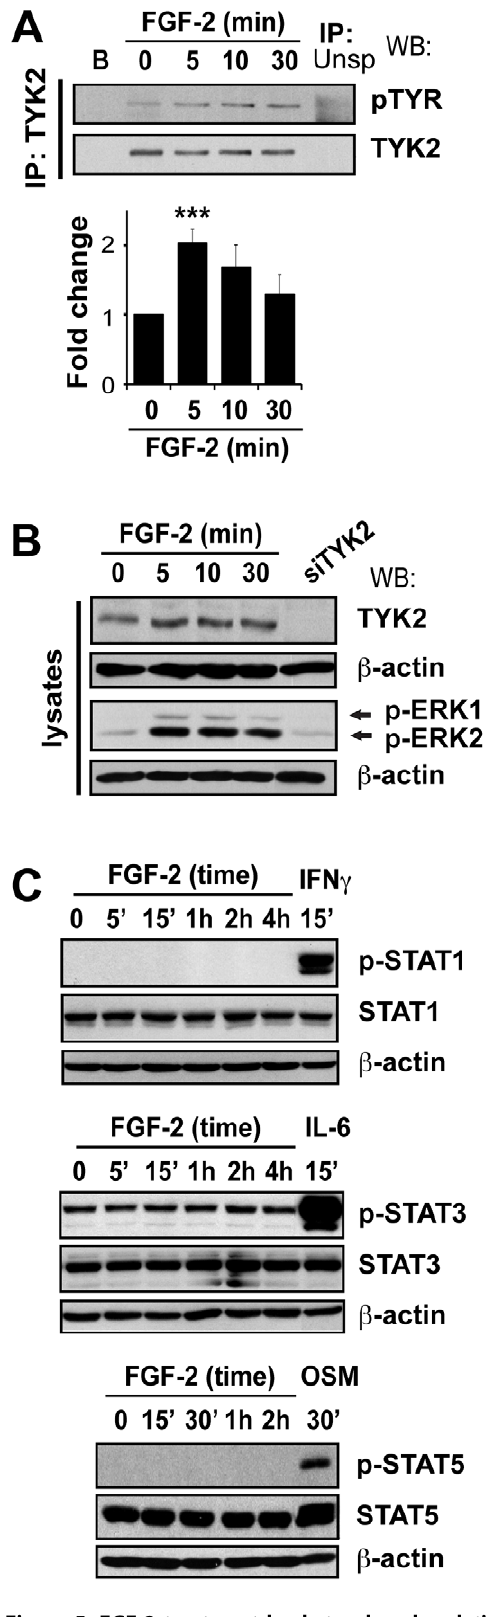
Figure 5. FGF-2 treatment leads to phosphorylation of TYK2, but not STAT1, STAT3 or STAT5A/B. A. FGF-2 did not induce STAT1, STAT3, or STAT5 phosphorylation. U2OS cells were